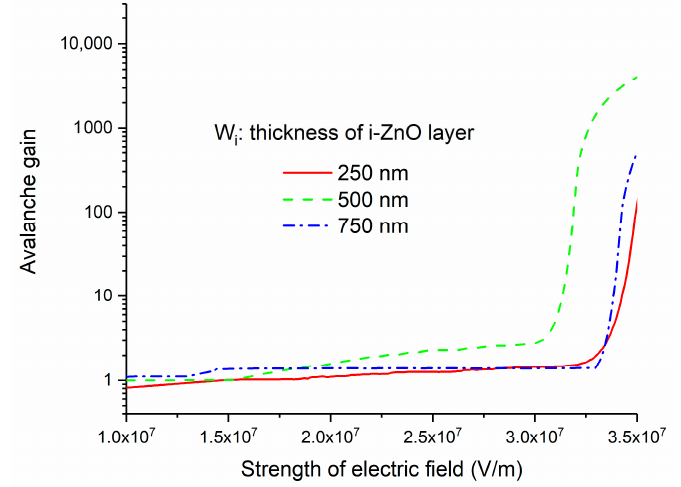
Figure 13. The I-V characteristics of p-Si / i-ZnO / n-AZO APD in dark and under illumination.